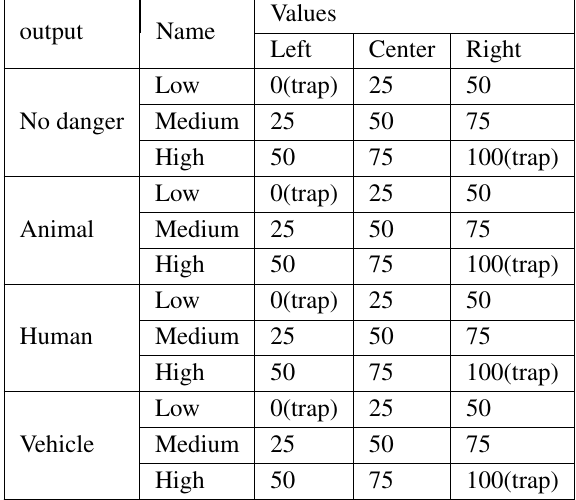
Table 2. Description of the membership functions of each